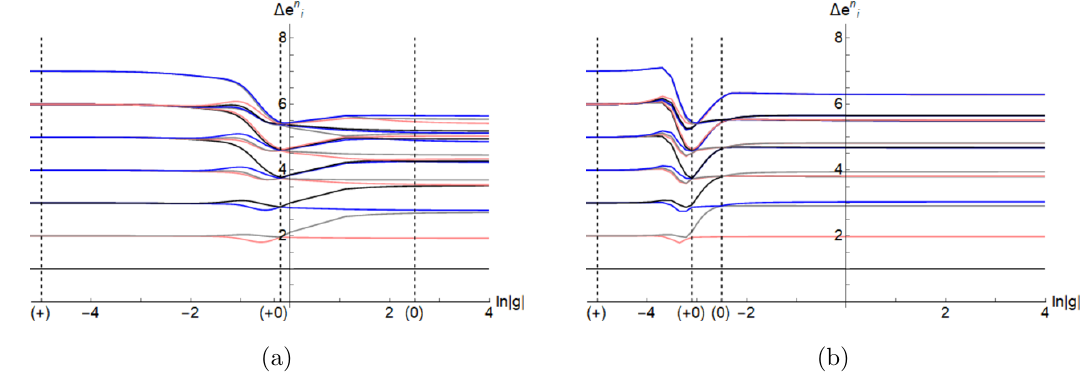
Figure 16. (a) T -perturbation of the (+) boundary condition with the identity spectator in TIM, positive coupling (cid:1) max = 25; (b) T -perturbation of the (+) boundary condition with the identity spectator in TIM, negative coupling (cid:1) max =